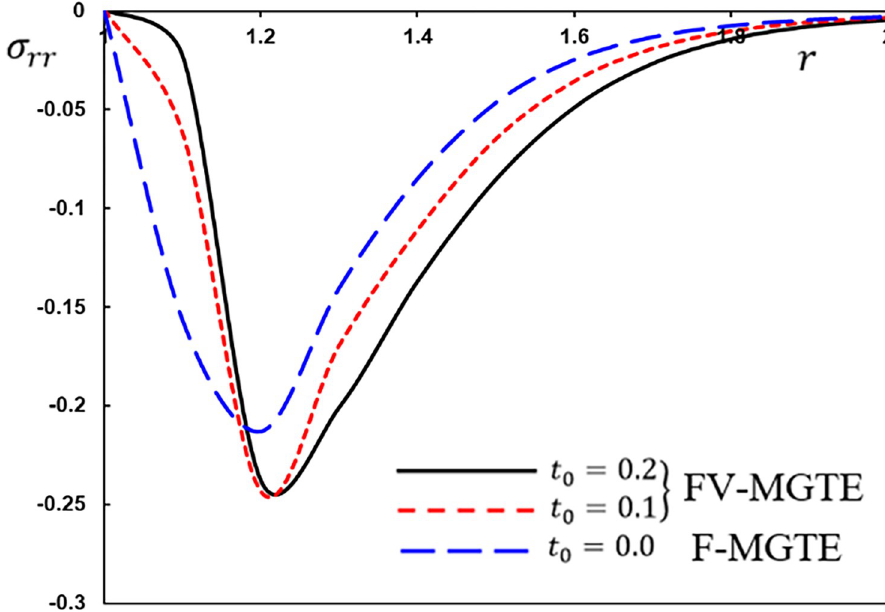
Fig 15. The radial stress variation σ